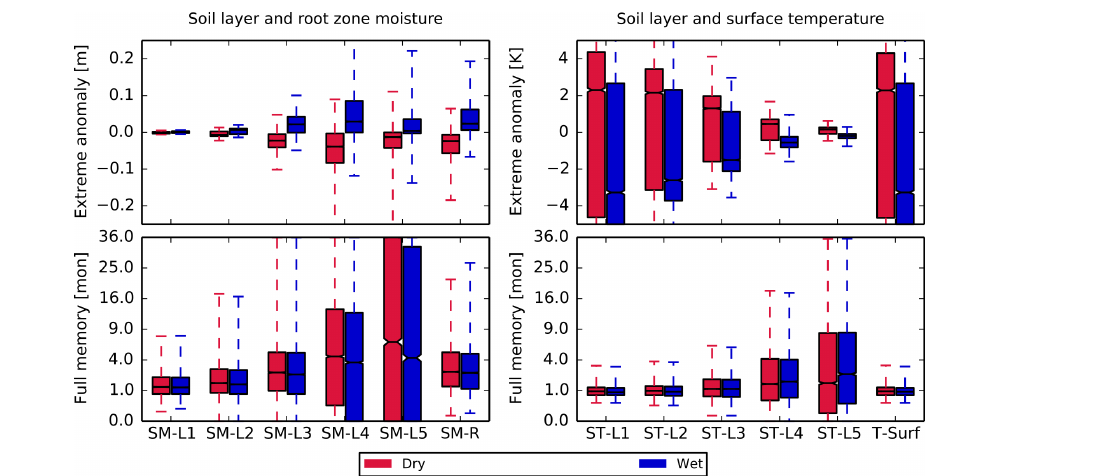
Figure 11. Global statistics for extreme anomalies (cid:49)θ max during the full time series (top panels) and accumulated memory τ max (bottom panels) in soil layer moisture (left side) and temperature (right side) in the wet (blue) and dry (red) initialized ensemble simulations. All land surface grid cells are